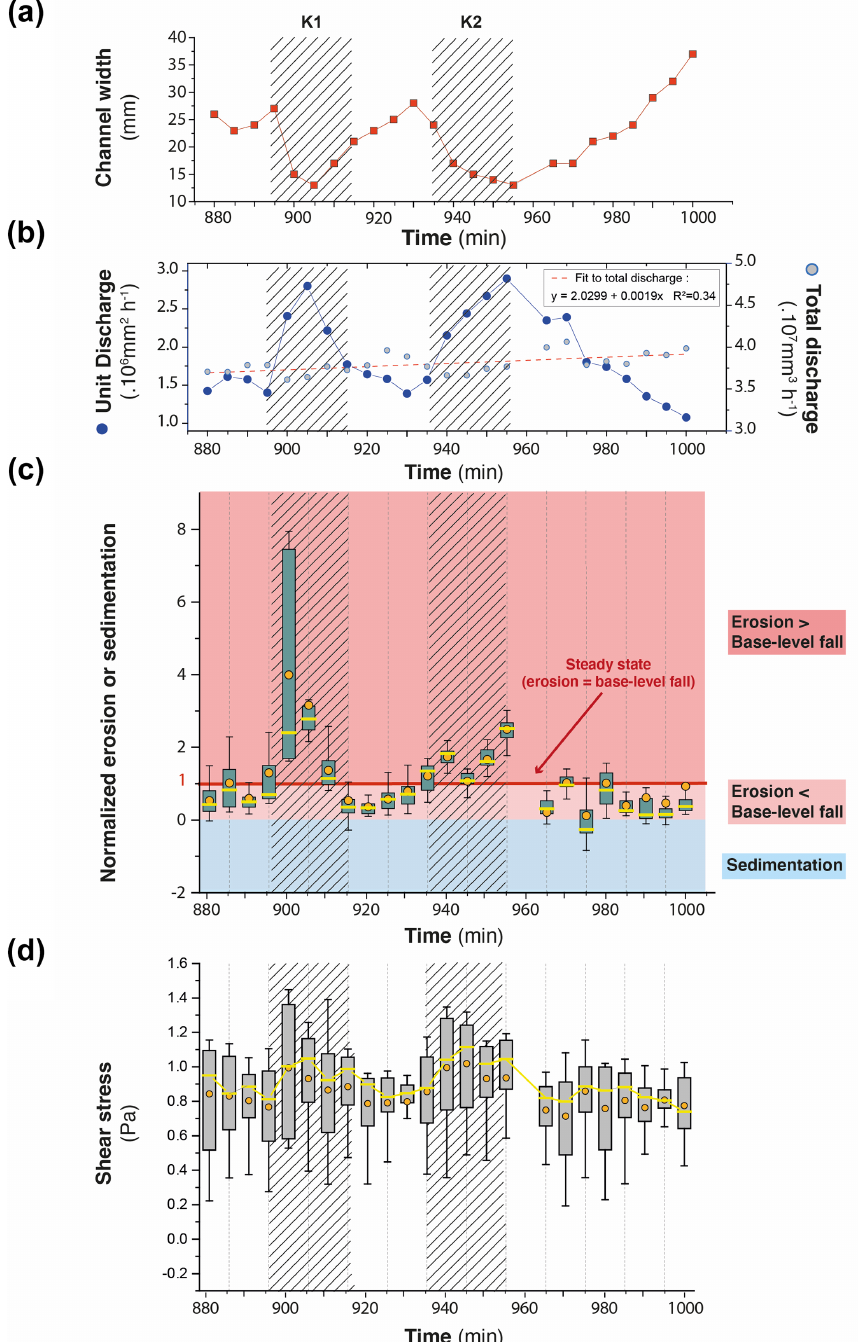
Figure 11. Time series (5min time interval) of river width (a) and unit and total discharge (b) for the channel in experiment BL15 shown in Fig. 10b (see also location of Fig. 10c). Time series of box-and-whisker plots of normalized erosion or sedimentation (c) and shear stress (d) for all pixels across the channel cross section. Solid orange circles and yellow lines show the mean and median values, respectively. Edges of the boxes indicate the 25th and 75th percentiles. Note that in (c) , normalized values of 1 indicate erosion at the same rate as base level fall (steady-state conditions). Values > 1 or < 1 indicate, respectively, a higher and lower erosion rate than BL fall rate. Negative values indicate sedimentation. On all graphs, crosshatched areas indicate the passage of knickpoints K1 and K2.